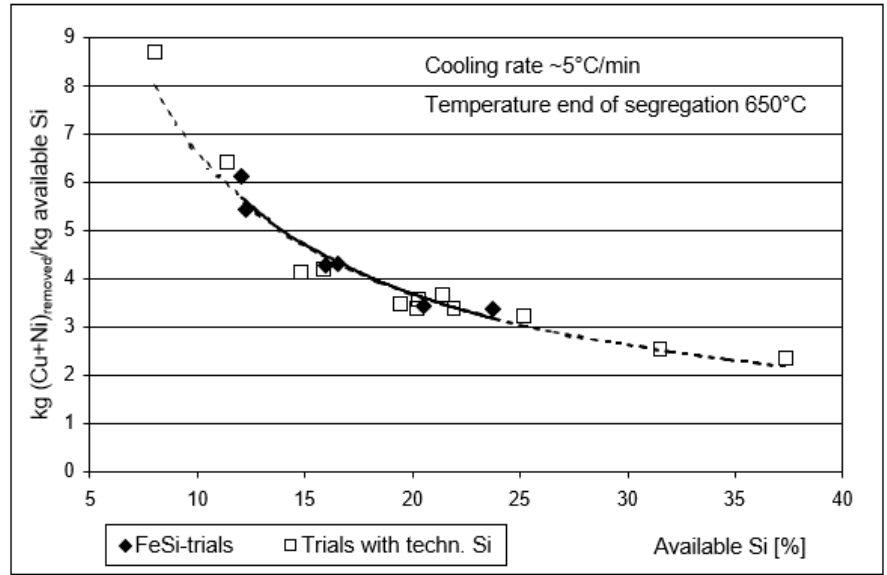
Figure 10. Cu and Ni mass removed from the PbSn composite per kg of “available” Si as a function of the “available” Si.